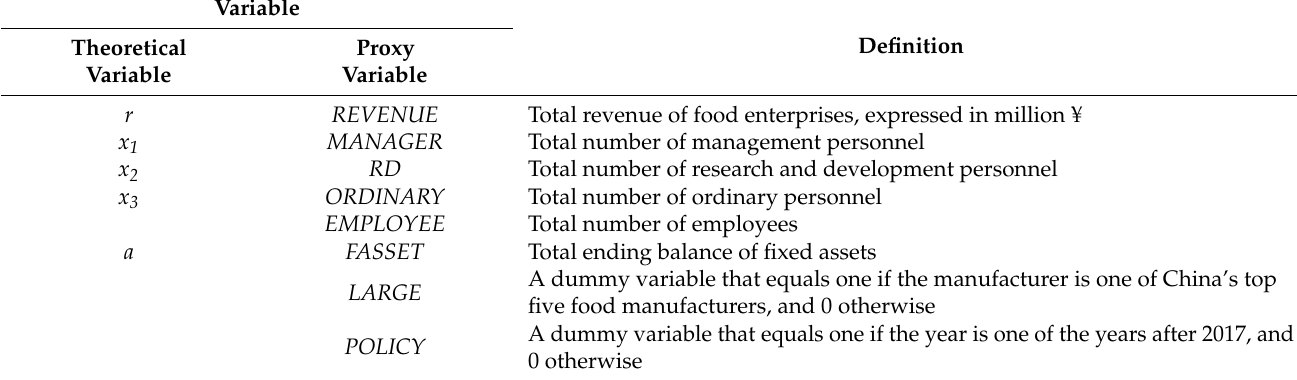
Table 2. Variable